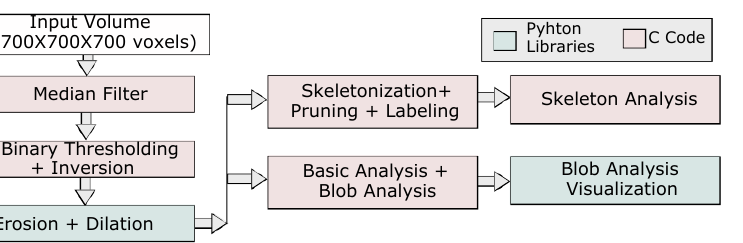
Figure 3. Processing and analysis protocol adopted for the volcanic data sets highlighting modules implemented in Python and modules implemented in C.